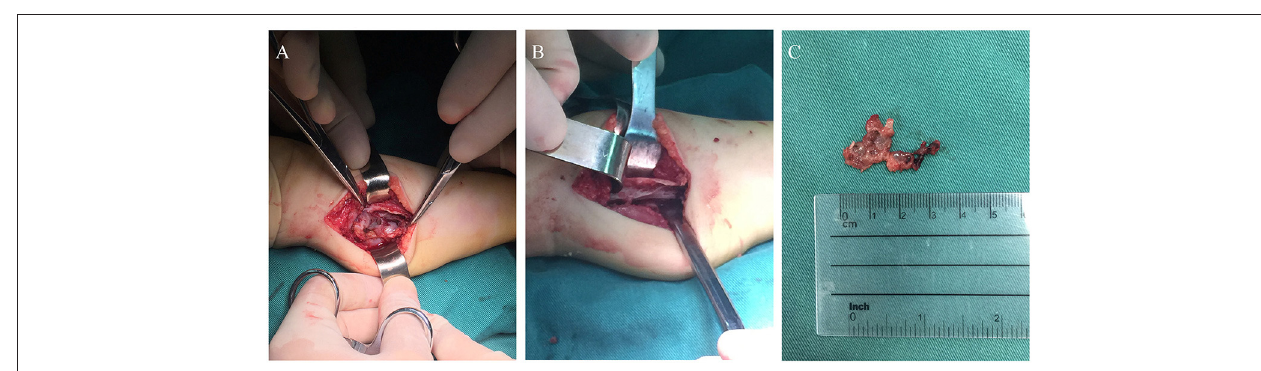
FIGURE 2 | The photograph during the surgery: (A) Intraoperative image of the surgical finding of a vascular mass attached to proximal fibula; (B) Complete curettage of lesion to normal fibular surface; (C) Macroscopic appearance of the excised